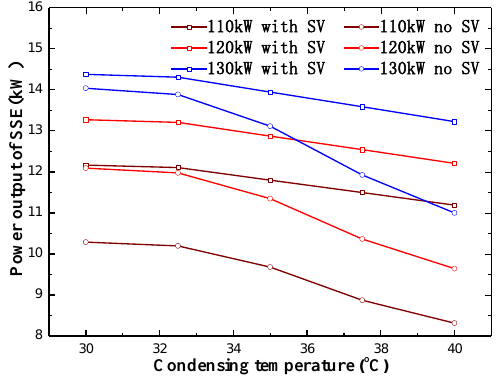
Figure 16. Power output of SSE vs. condensing temperature.